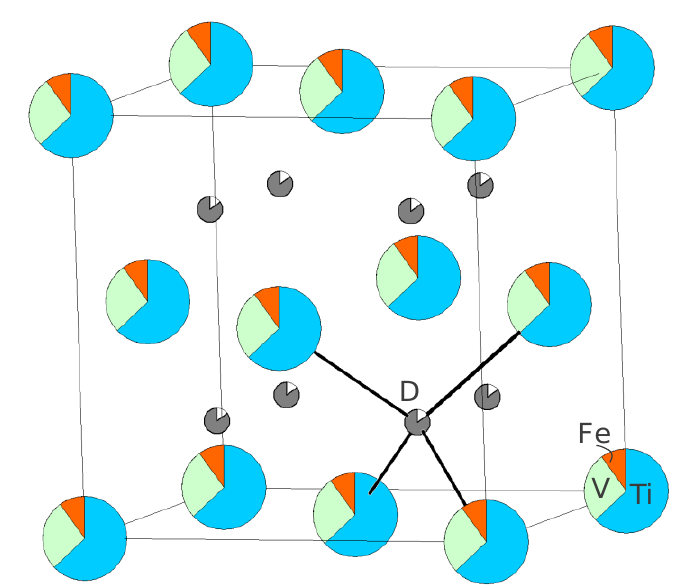
Figure 1. The crystallographic unit cell of the face-centered cubic (FCC) hydride of a body-centered cubic (BCC) Ti-V-Fe-based alloy.